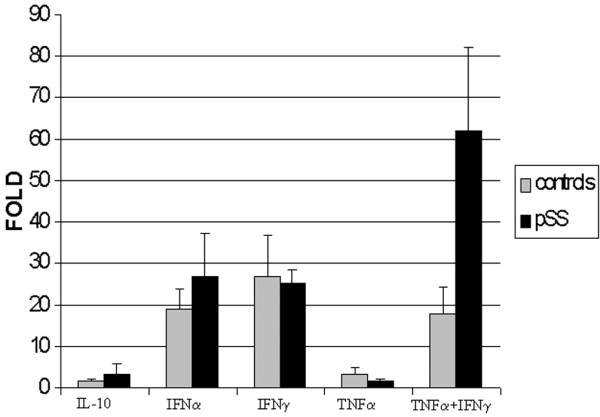
Induction of BAFF mRNA by epithelial cells from minor salivary glands. Results are from seven patients with pSS and from seven controls, 48 hours after stimulation with IL-10 (100 ng/ml), IFN-α (2,400 U/ml), IFN-γ (5 ng/ml), tumor necrosis factor (TNF)-α (1 ng/ml) and IFN-γ (5 ng/ml) + TNF-α (1 ng/ml). All samples were processed in duplicate. Error bars indicate SEM. BAFF, B cell-activating factor.